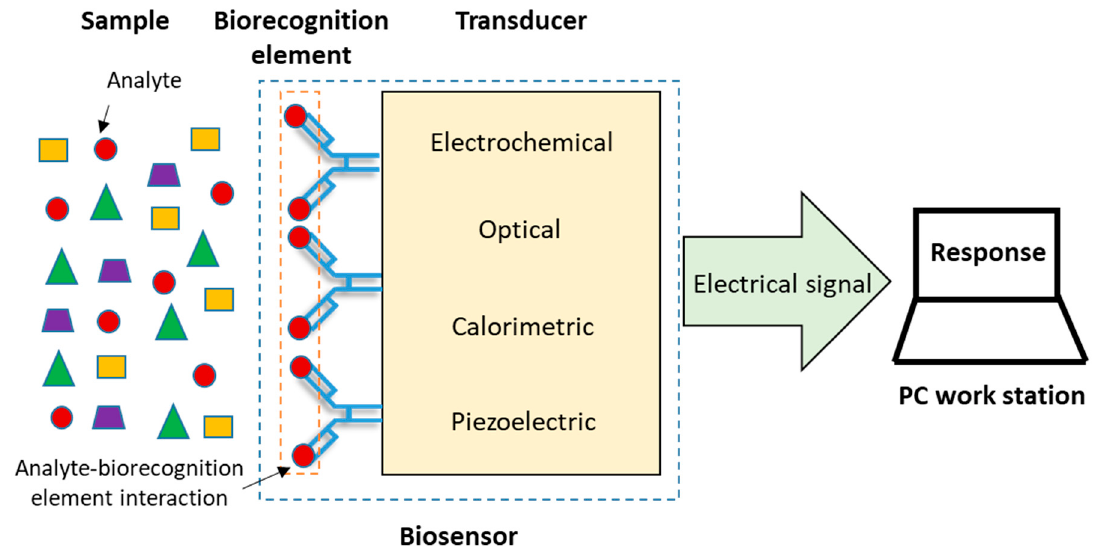
Figure 1. Components of a biosensor [2].